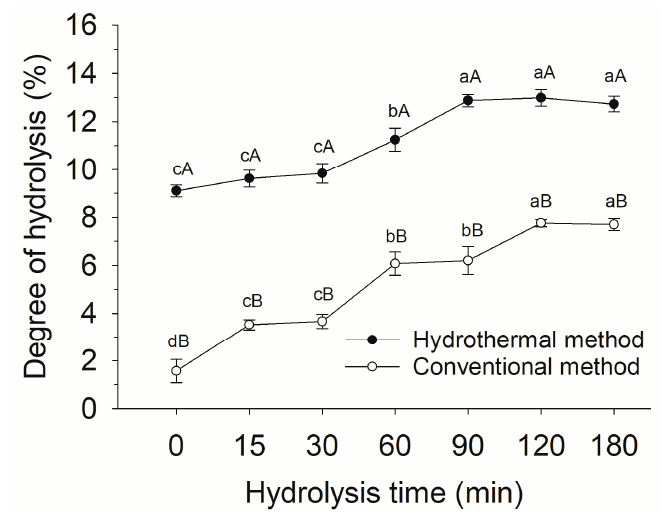
Figure 3. Degree of hydrolysis of gelatin hydrolysates of fish scales treated by hydrothermal and conventional methods followed by alcalase hydrolysis. Different small letters indicate that the results at different hydrolysis time within the sample differ signi fi cantly ( p < 0.05). Different capital letters indicate that the results between the samples treated by two methods differ signi fi cantly ( p < 0.05).